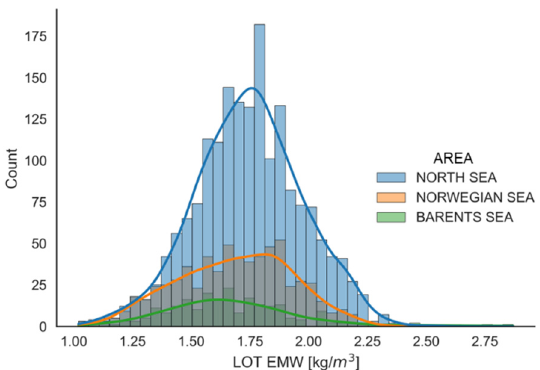
Figure 2. Histograms of leak-off pressures for the three geographical areas.